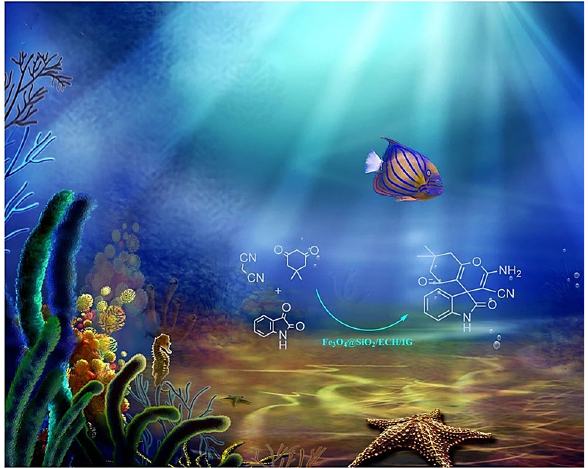
Figure 2. Collagen-coated superparamagnetic iron oxide nanoparticles as a sustainable bio-based catalyst for the direct synthesis of spirooxindole (software used: ChemDraw Ultra 12.0 and Paint 3D).